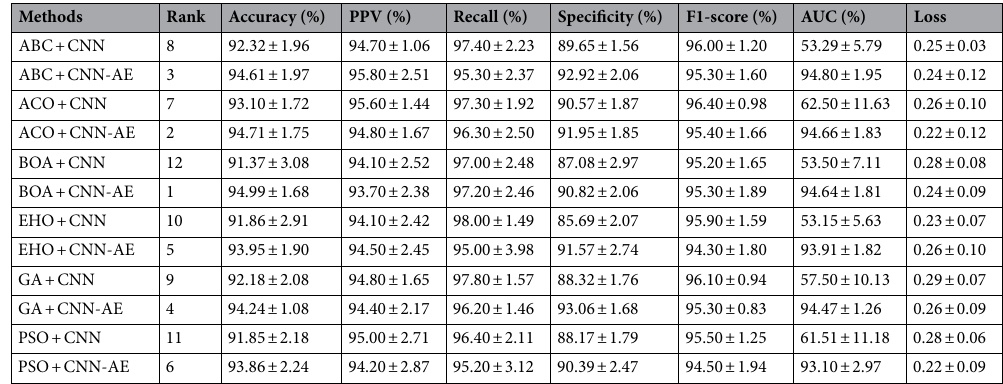
Table 11. CNN and CNN-AE performance trained on features selected by meta-heuristic methods.